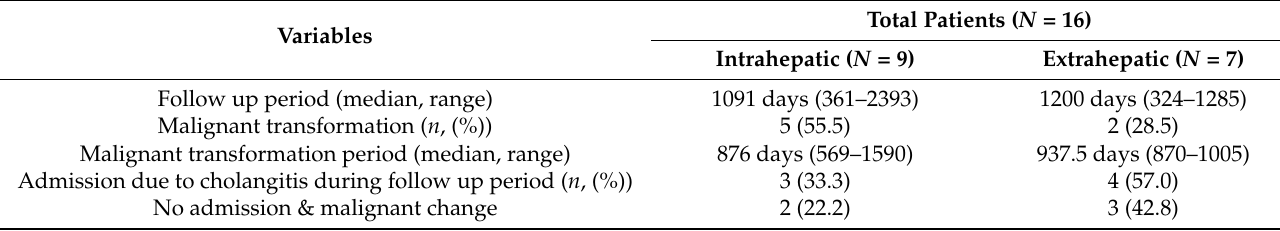
Table 5. prognosis of non-operative IPNB